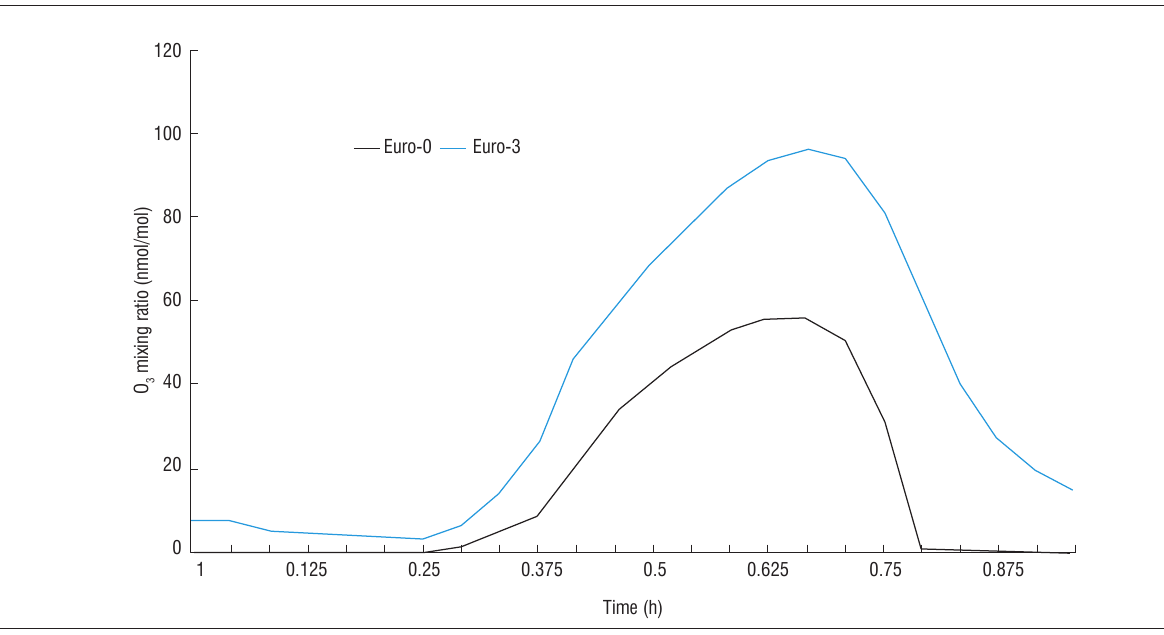
production in the Johannesburg-Pretoria megacity by changing from Euro-0 to Euro-3 classified Figure 7: Comparison of O 3